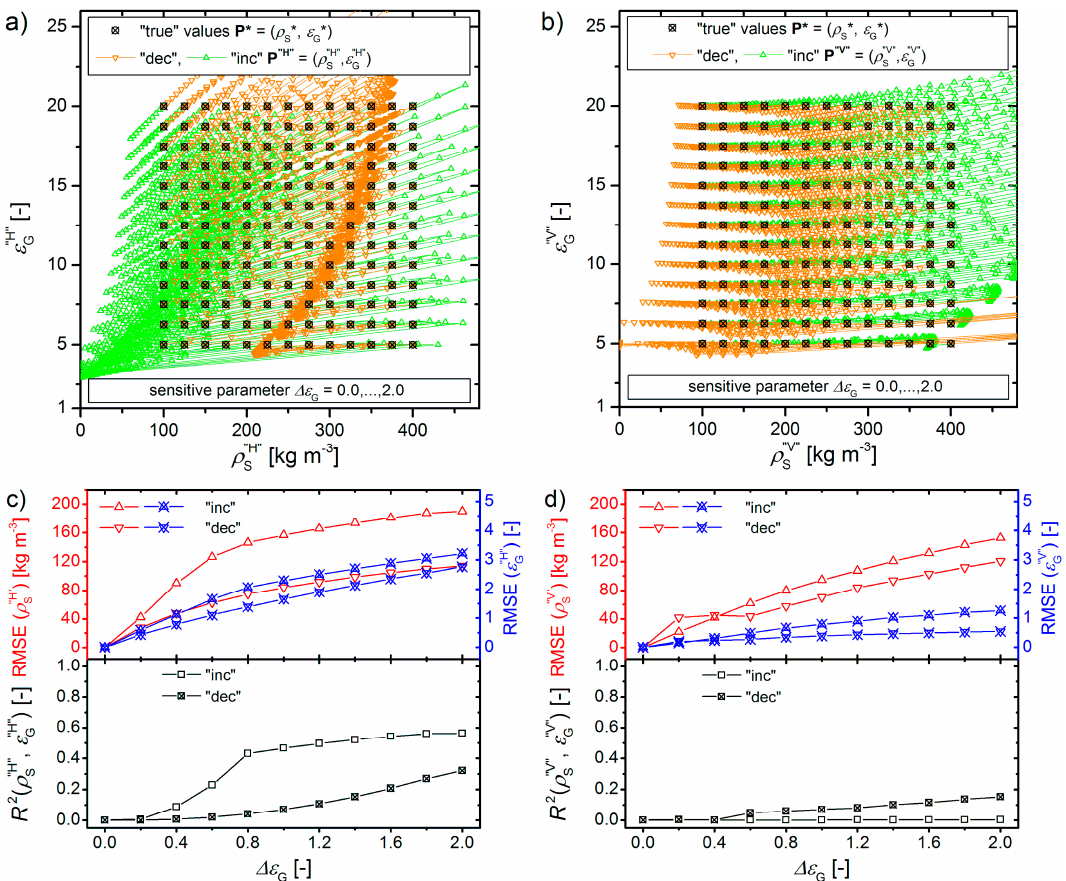
(cid:0) (cid:1) ρ RM , ε RM for RM = “H” (panel ( a )) and “V” (panel S G ≤ 400 kg m − 3 and 5 ≤ ε ∗ ≤ 20. For S G